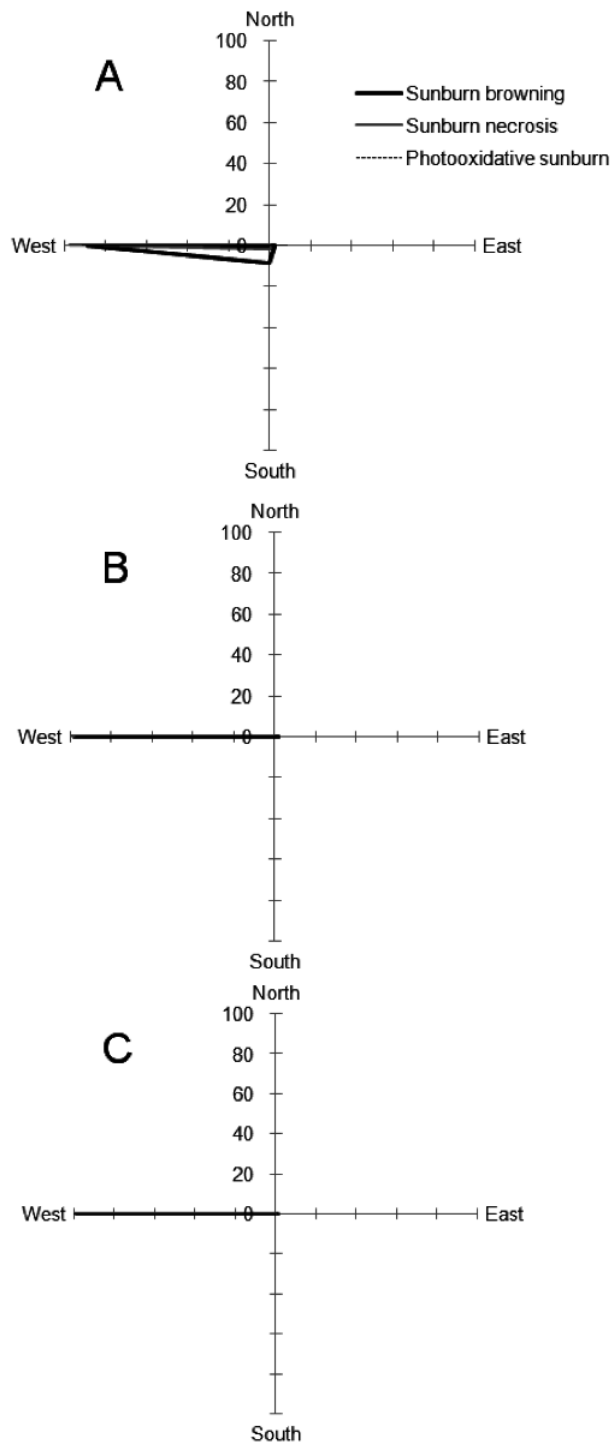
Fig. 2. The proportion of the three sunburn types of ‘Smoothee’ cultivar on M.9 (A), MM.106 (B) and seedling (C) rootstocks at each quadrant (N, E, S, and W) of the canopy. Data are based on the average of 2006 and